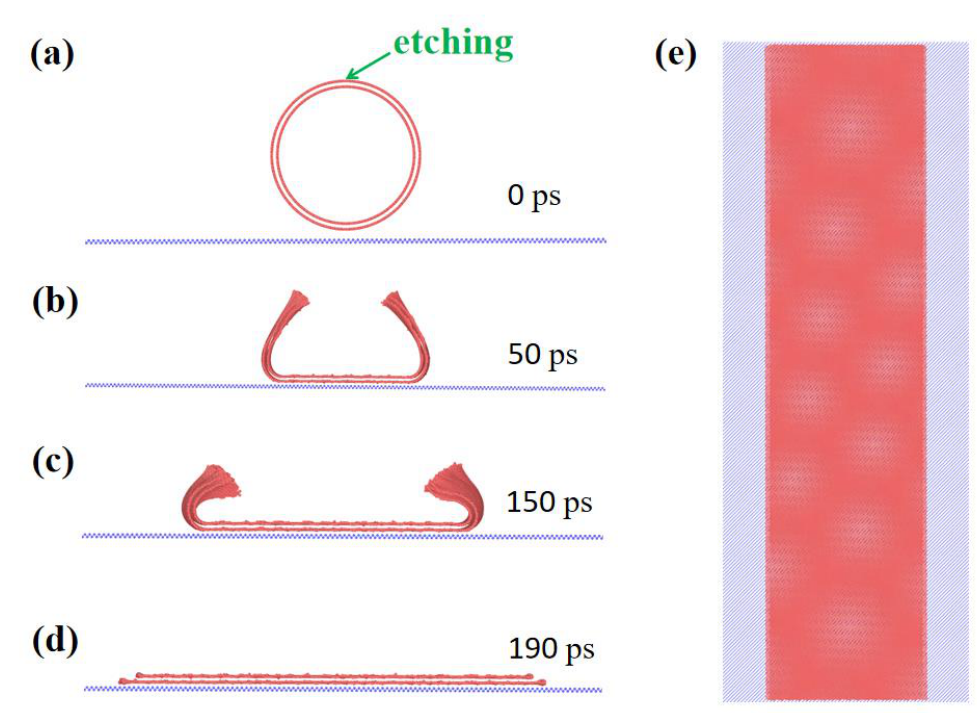
Figure 6. Unzipping a twisted (91,18)/(97,22) SWCNT via etching on substrate at 1 K, the twist angle is 1.14 ◦ and become 1.16 ◦ after collapsing onto the substrate. The snapshots are given in ( a – d ), the top view of the yielded moire pattern is shown in ( e ). The size of the unzipped bilayer graphene is 24.88 nm × 100 nm and 26.95 nm × 100 nm.